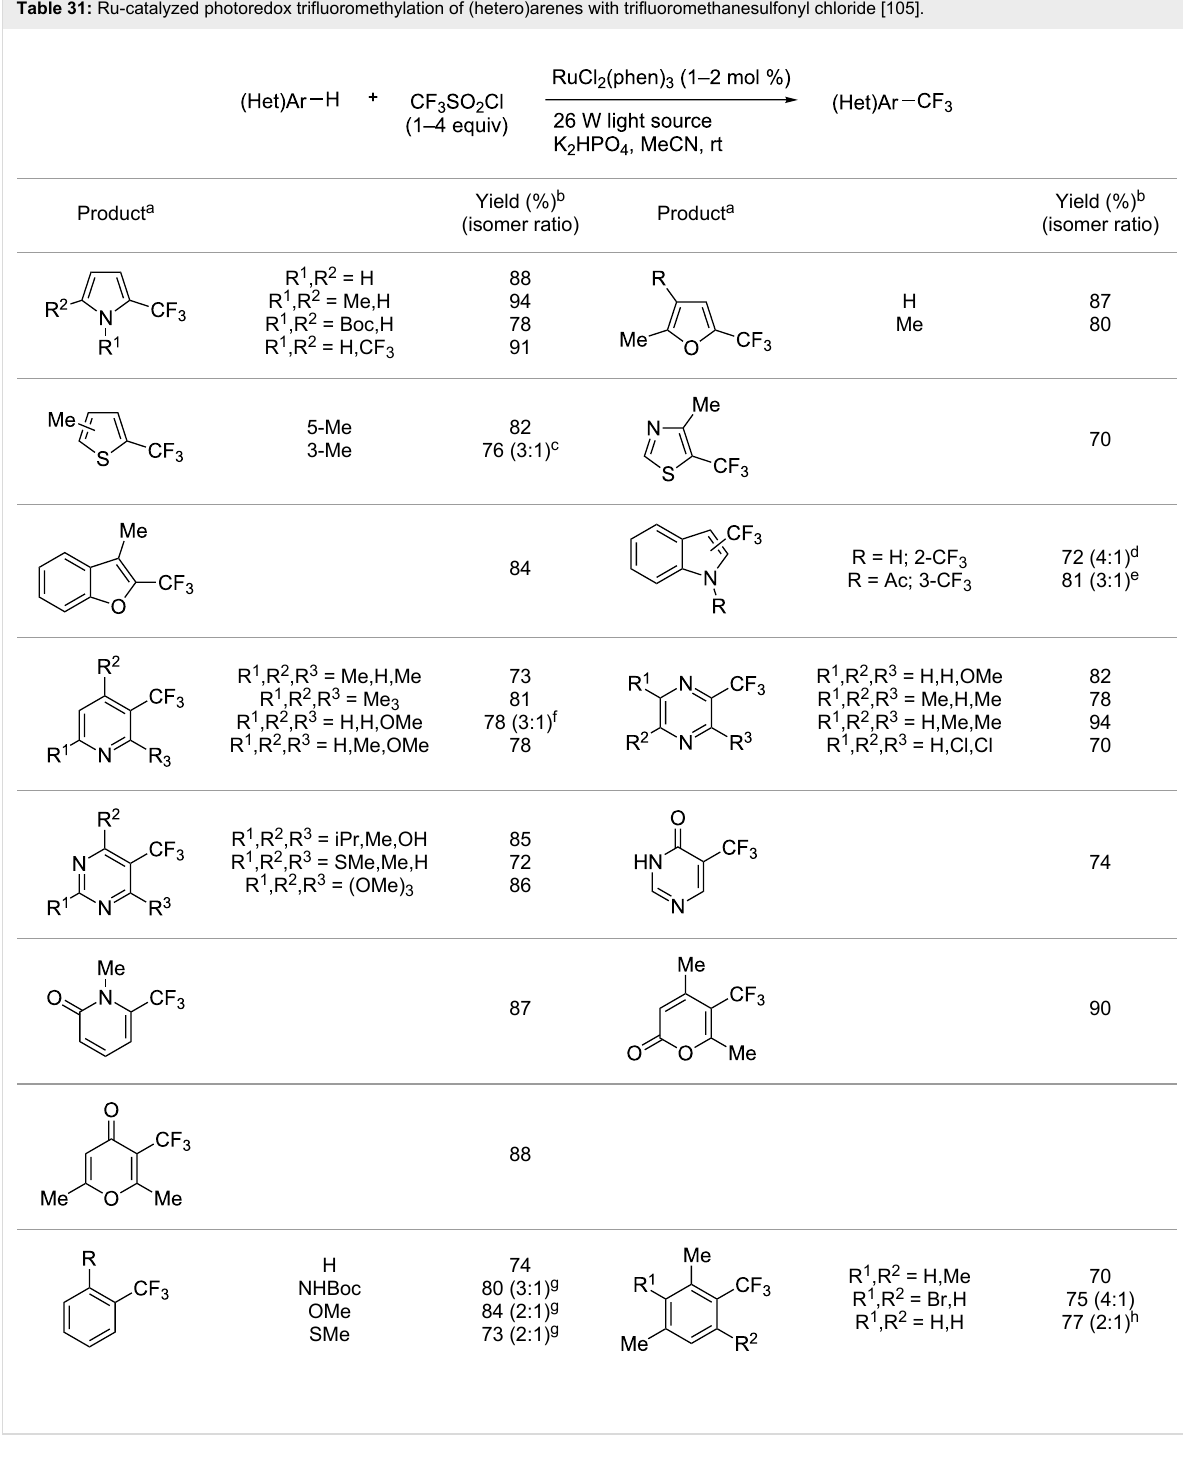
Table 31: Ru-catalyzed photoredox trifluoromethylation of (hetero)arenes with trifluoromethanesulfonyl chloride [105].